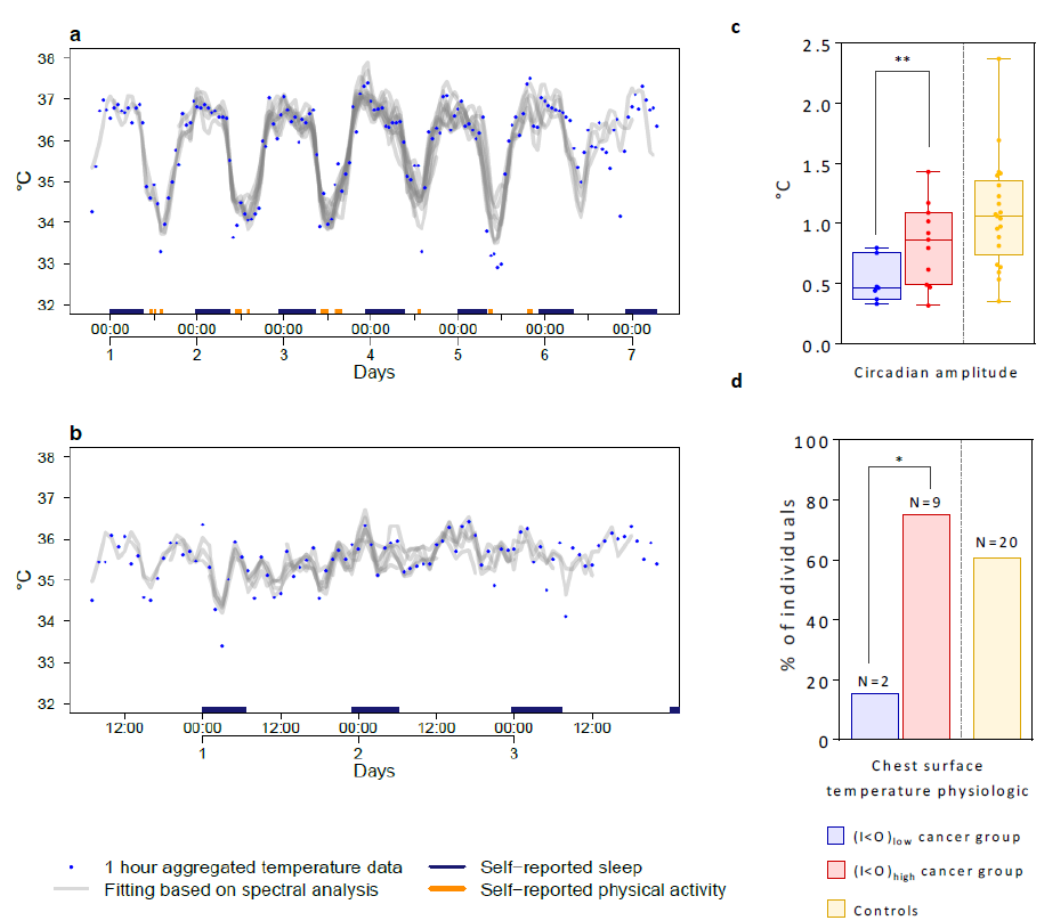
Figure 5. Chest surface temperature patterns and boxplots comparing the parameters of the tele- transmitted temperature patterns in (I < O) low and (I < O) high cancer groups, and in controls. ( a ) Time plot of chest surface temperature and curve fitting using spectral analysis for an example (I < O) high patient with an I < O value of 99.1%. The color bars on the abscissa represent the patient’s self -reported sleeping and physical exercise spans. ( b ) Time plot of chest surface temperature for an example (I < O) low patient with an I < O value of 86.5%. ( c ) Box plots showing the distribution of the chest surface temperature circadian amplitude for the two I < O patient and control groups. Bars represent the extremes and bold lines inside the box plots plot median levels. Values for each individual are plotted as jittered dots to better show the distribution. ( d ) Bar graphs of the proportion of individuals with a physiologic chest surface temperature in each I < O patient group and controls. Levels of significance: ** 0.001< p ≤0.01 (two - tailed Welch’s modified t -test in (c)); * 0.01< p ≤0.05 (Fisher’s exact test in (d)).